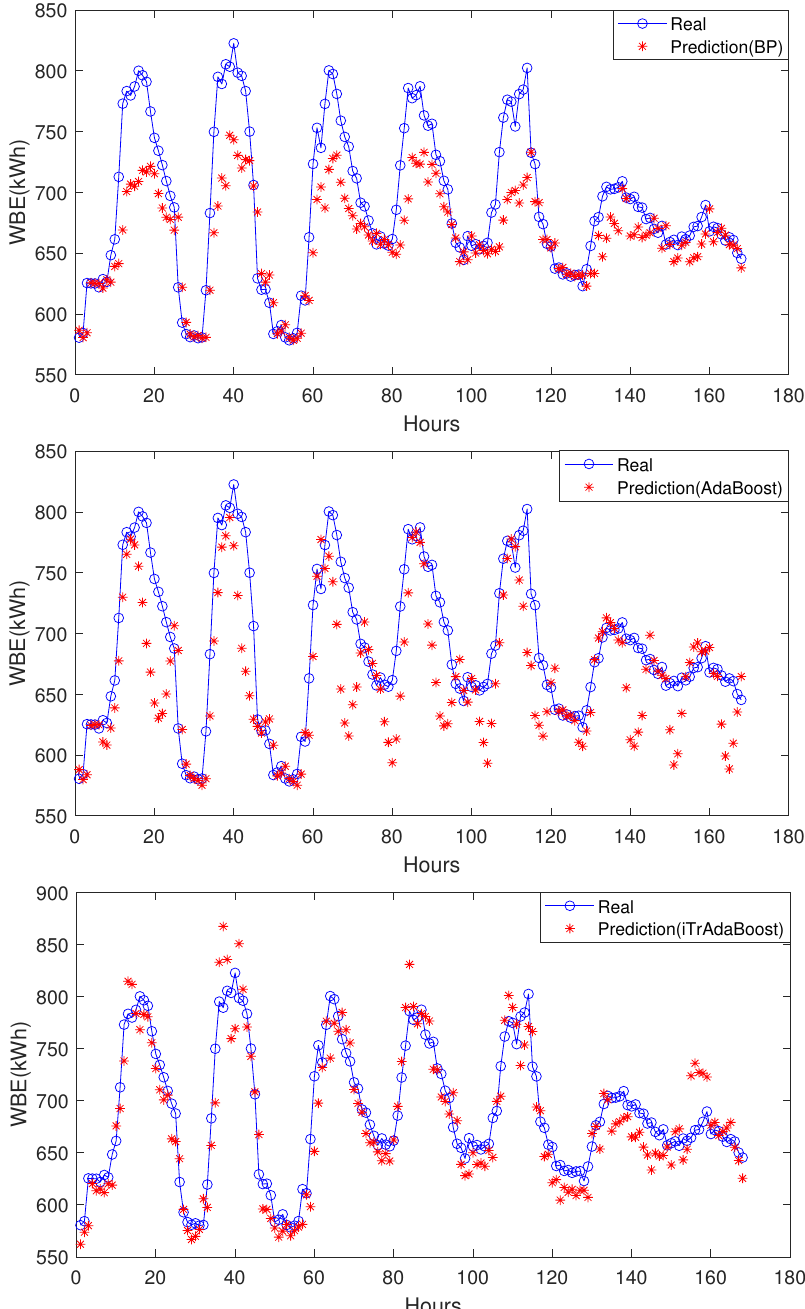
Figure 11. Real and predicted electricity loads using three predictive models, no MMD, one week’s